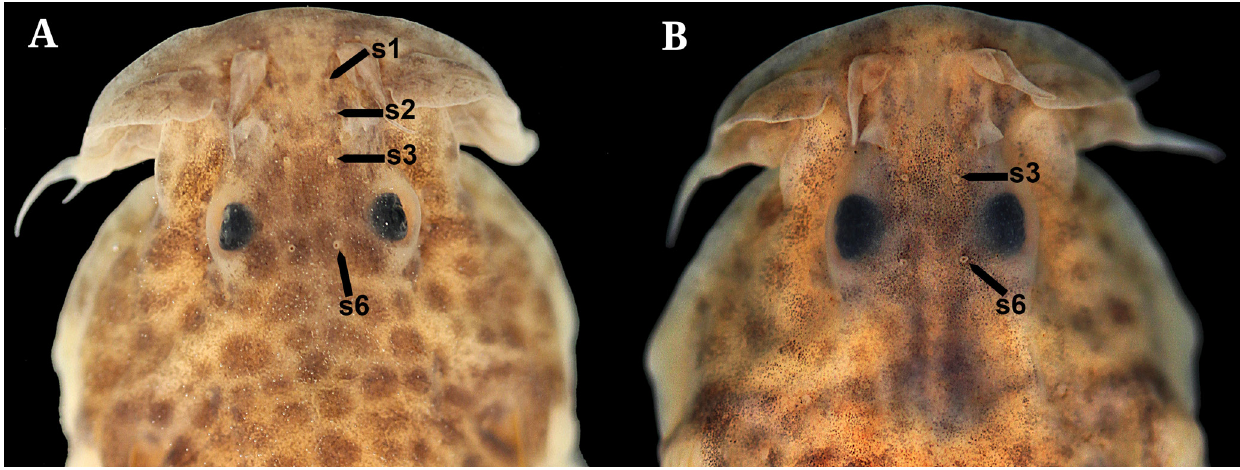
FIGURE 10 | Dorsal view of the head of A. Scleronema macanuda , new species, paratype (UFRGS 21635; 75.6 mm SL) and B. S. operculatum (UFRGS 19646; 56.1 mm SL) showing the pores of the laterosensory